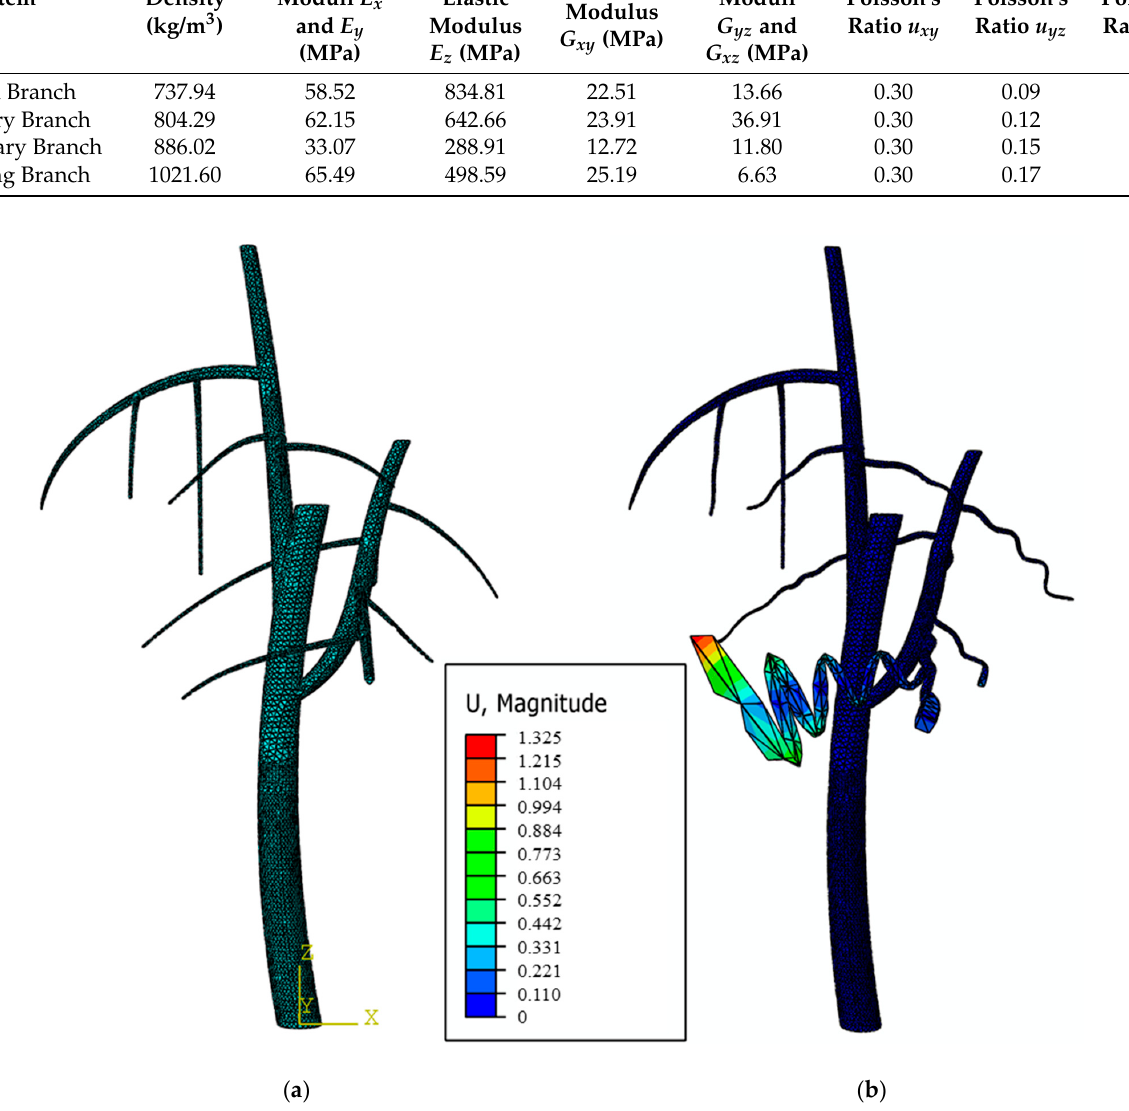
Figure 4. The meshed shrub based on FEM simulation ( a ) and the simulation result of the shrub at the optimized resonance frequency ( b ).